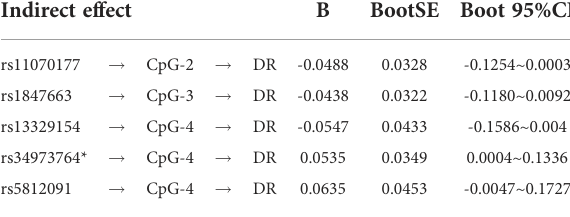
TABLE 4 The results of mediation